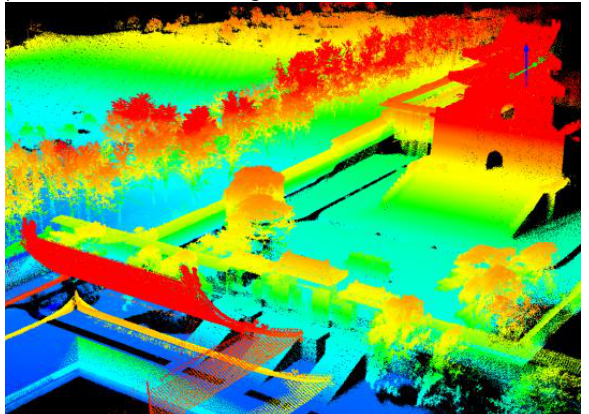
Figure 20 scanning data of an ancient building complex